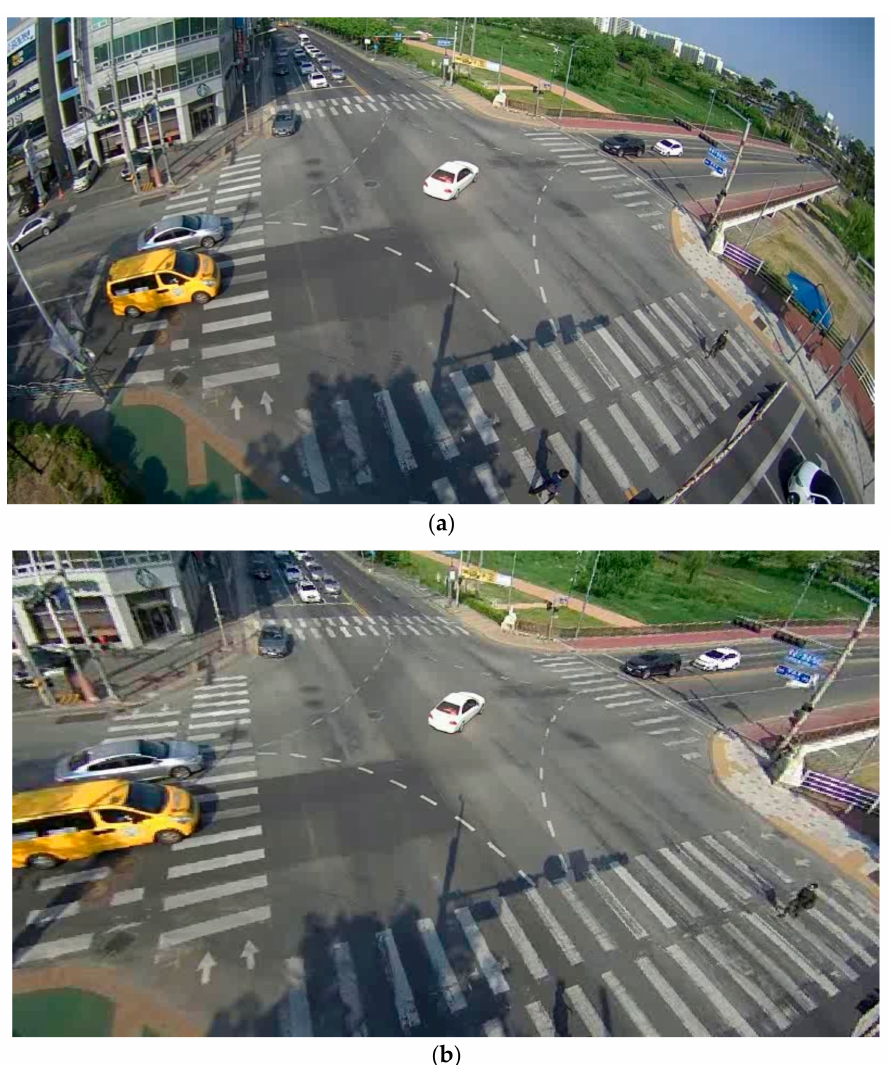
Figure 2. Example of lens distortion: ( a ) lens-distorted image; ( b ) image calibrated through camera